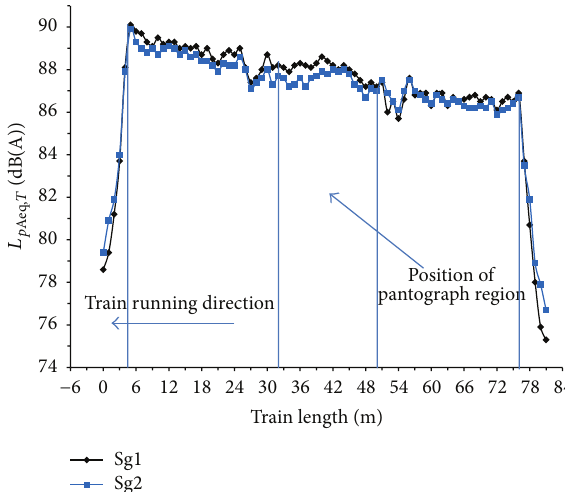
Figure 28: Comparison of the longitudinal SPL distributions for different pantograph lifting configurations on a high-speed train.